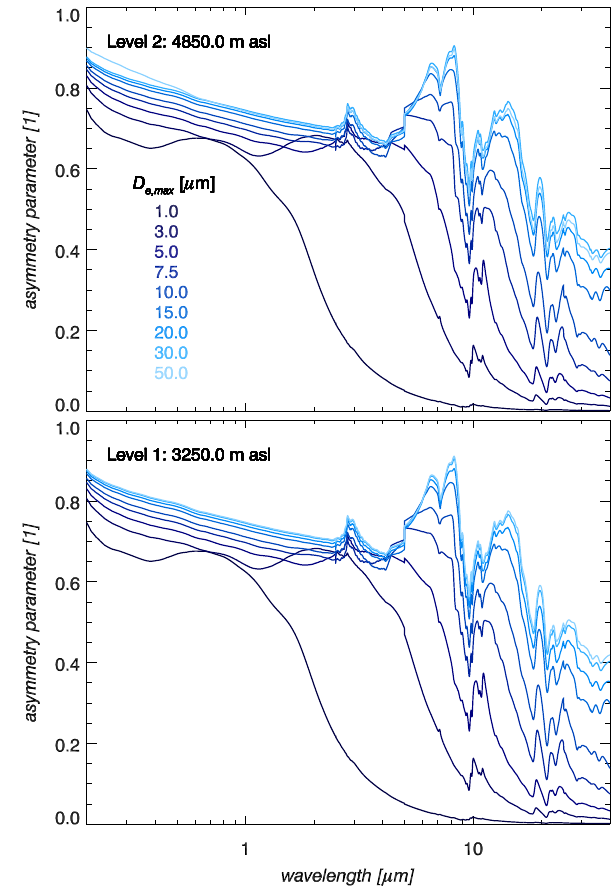
Fig. 5. The same as in Fig. 4, but for asymmetry